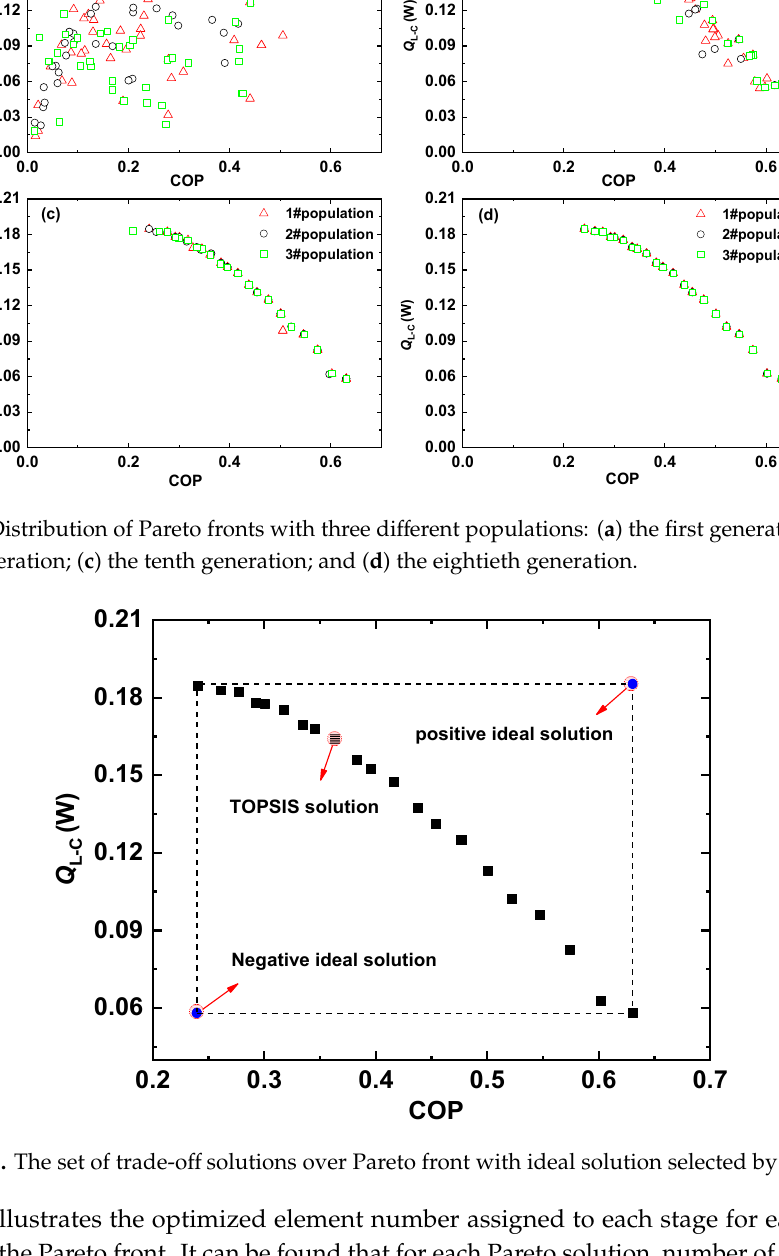
Figure 8. The set of trade-off solutions over Pareto front with ideal solution selected by TOPSIS.